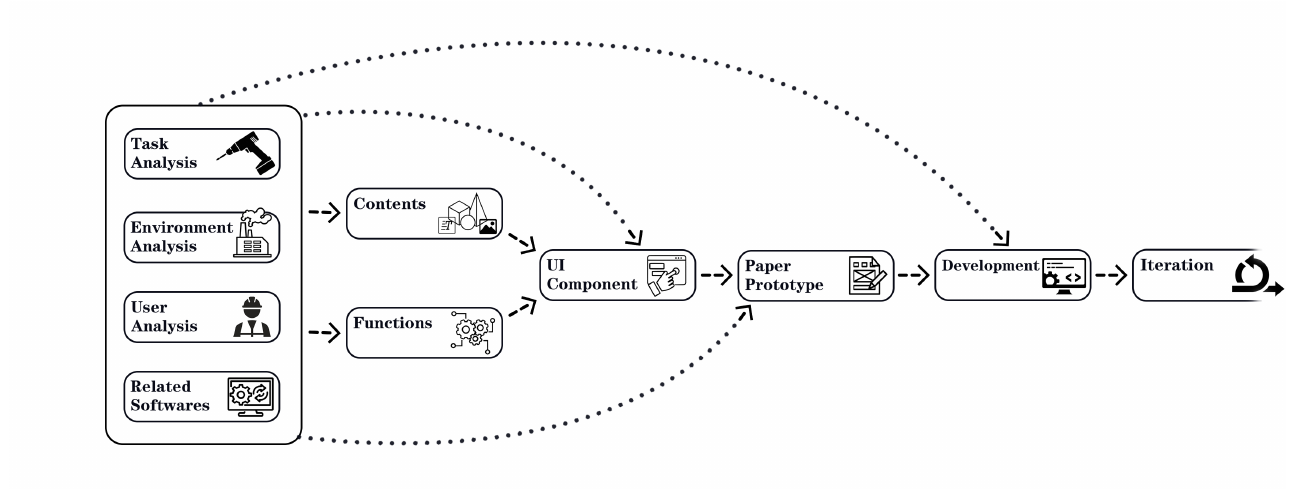
Figure 3. Software Platform Development